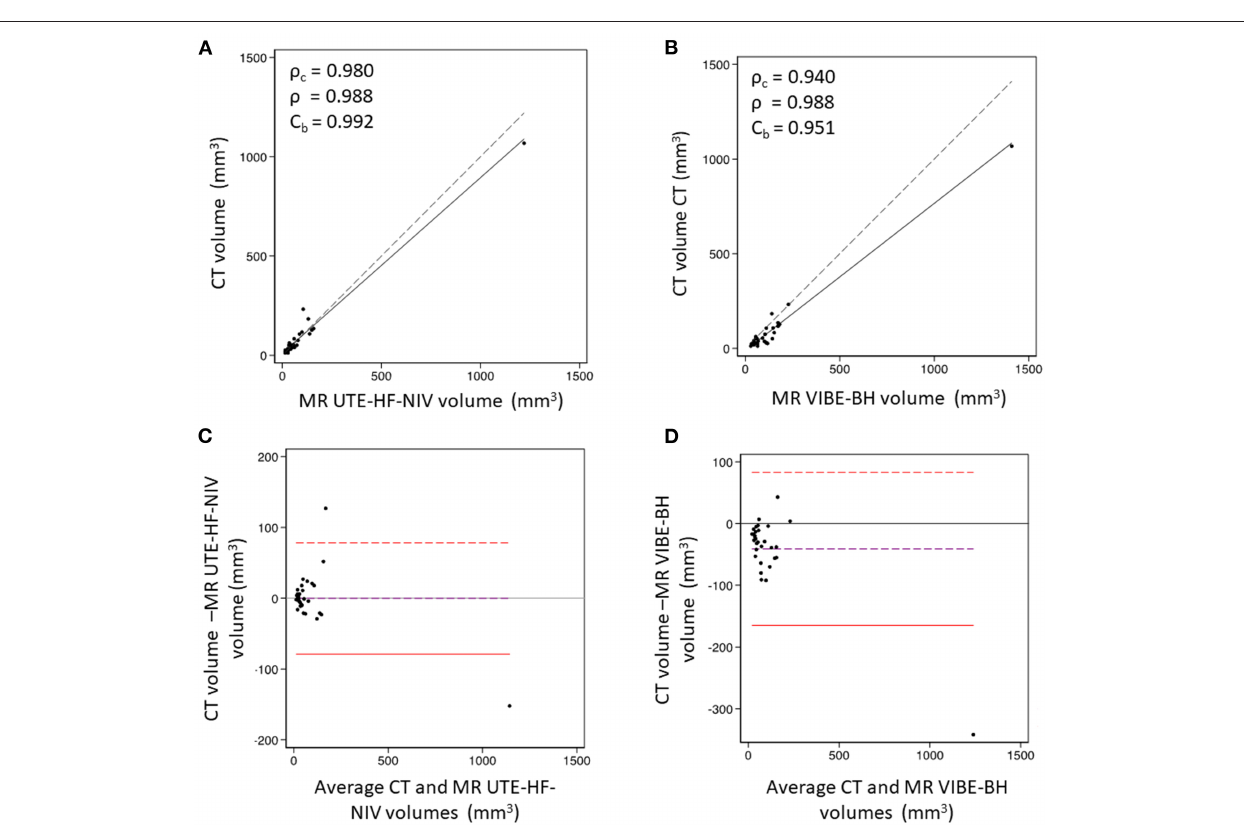
Frontiers in Medicine |